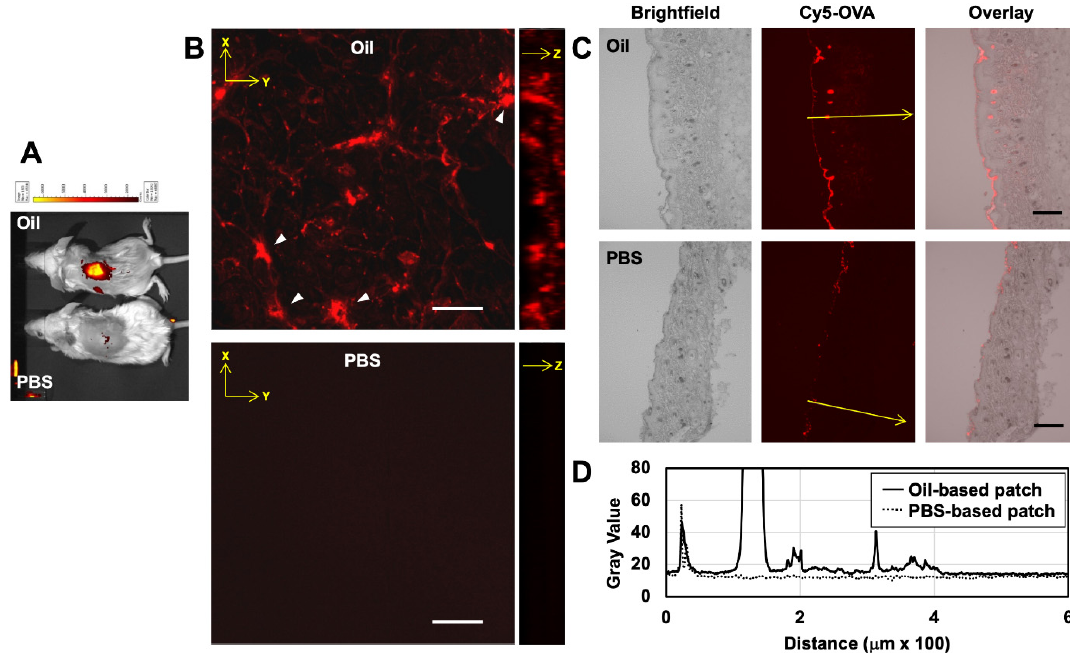
Figure 5. Transdermal delivery of Cy5-labeled ovalbumin (OVA) on mouse back skin using an oil-based patch (Oil) and a PBS-based patch (PBS) ( n = 3). ( A ) Diffusion of the Cy5-OVA on the mouse back. ( B ) Confocal laser scanning fluorescence microscope images of mouse back skins treated with an oil-based patch and a PBS-based patch. OVA-captured cells are indicated by white triangles. ( C ) Fluorescence microscope images of mouse back skins sectioned at a 16- µ m thickness. ( D ) Pixel intensity profiles of the positions are shown by arrows. Bars indicate 50 µ m ( B ) and 200 µ m ( C ).